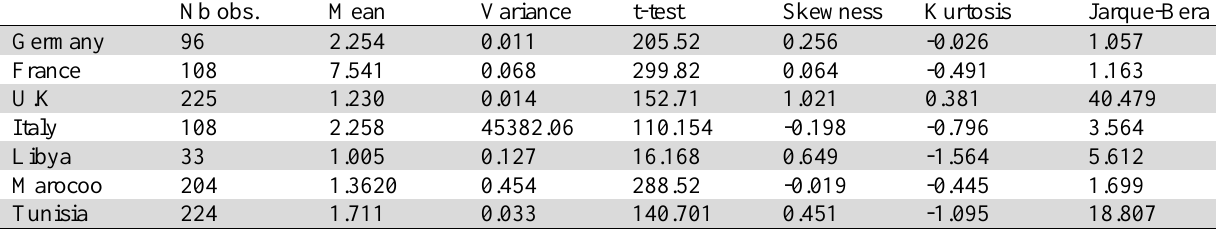
Descriptive statistics of the real exchange rate Nb